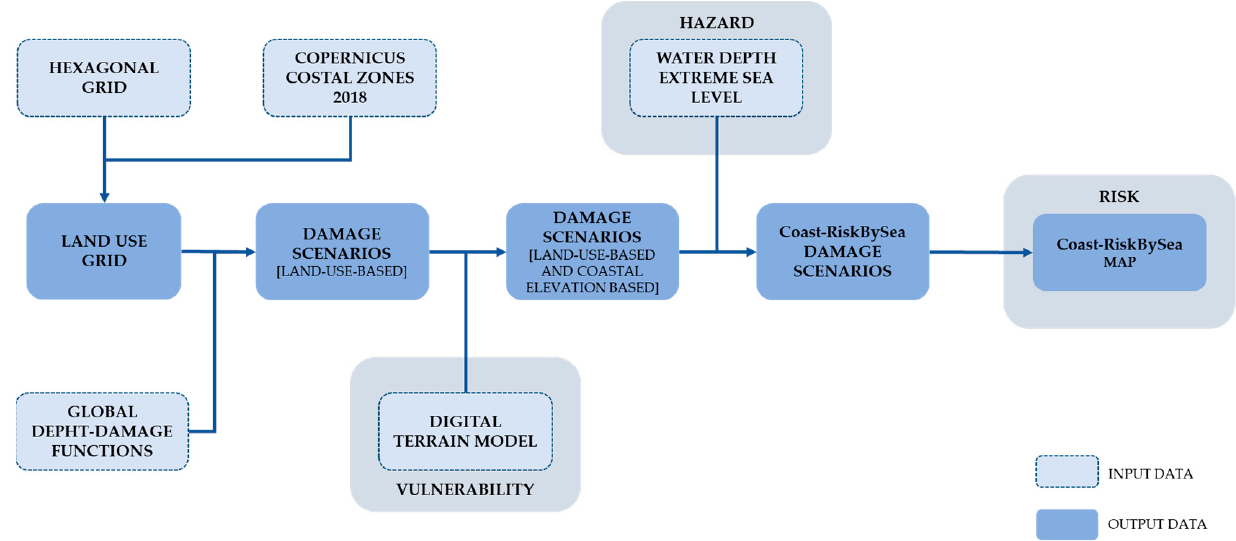
Figure 2. The Coast-RiskBySea model workflow based on [42].